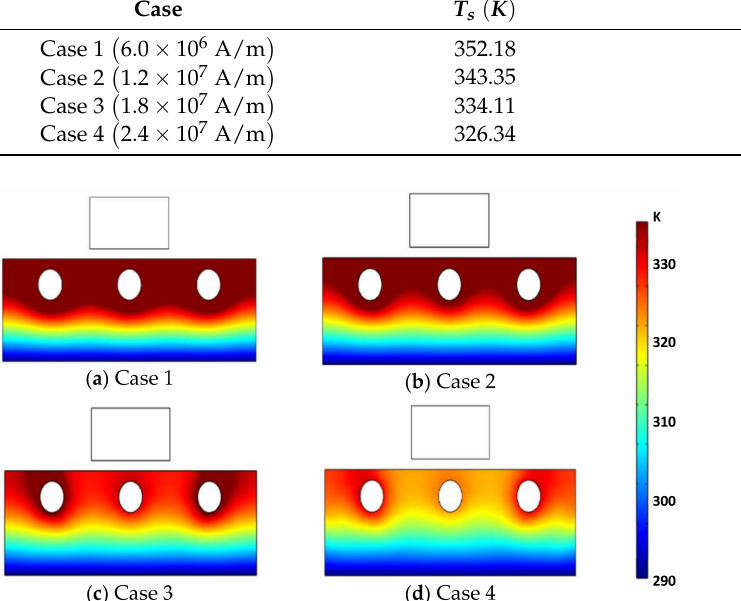
Figure 7. Temperature contours in the case of one permanent magnet (Case